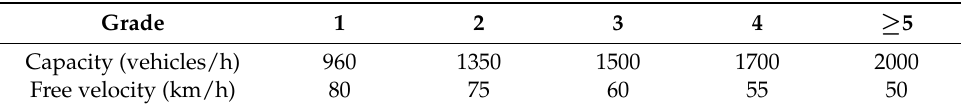
Figure 6. The main vulnerable roads in the emergency network. In our experiments, material supply, demand, road capacity, and travel time are dynamic. (1) The dynamic material supplies are set as shown in Figure 7a according to related real reports and the construction standard of disaster relief material reserves in China. (2) In this experiment, the initial demands are fixed and then piece-wise increase considering consumption periodically, as